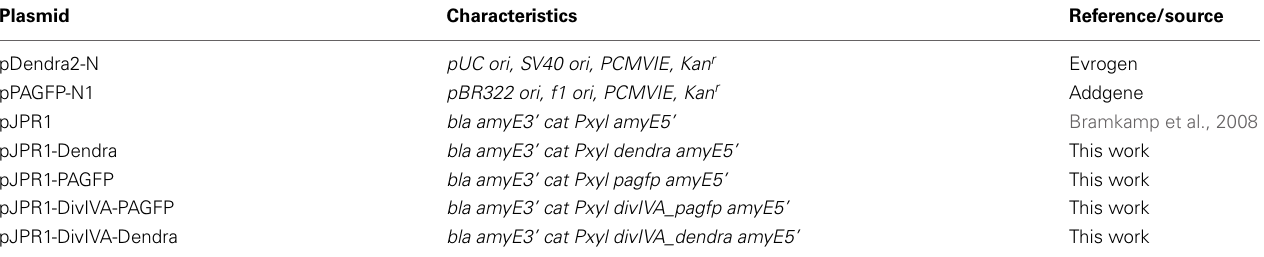
Table 2 | Plasmids used in this study. Plasmid